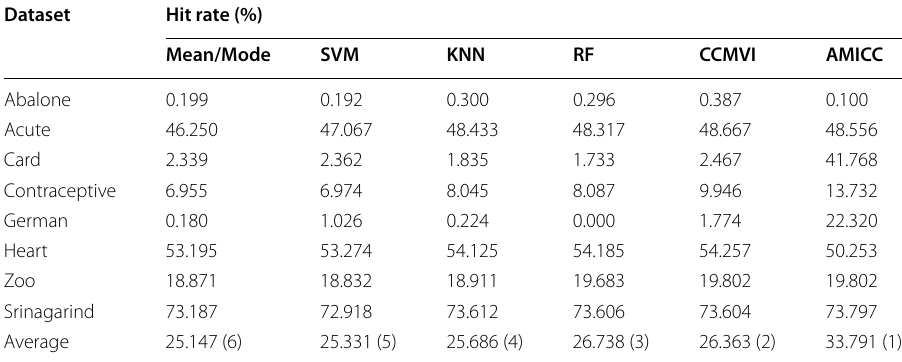
Table 13 Average hit rates of the MVI methods for the mixed datasets